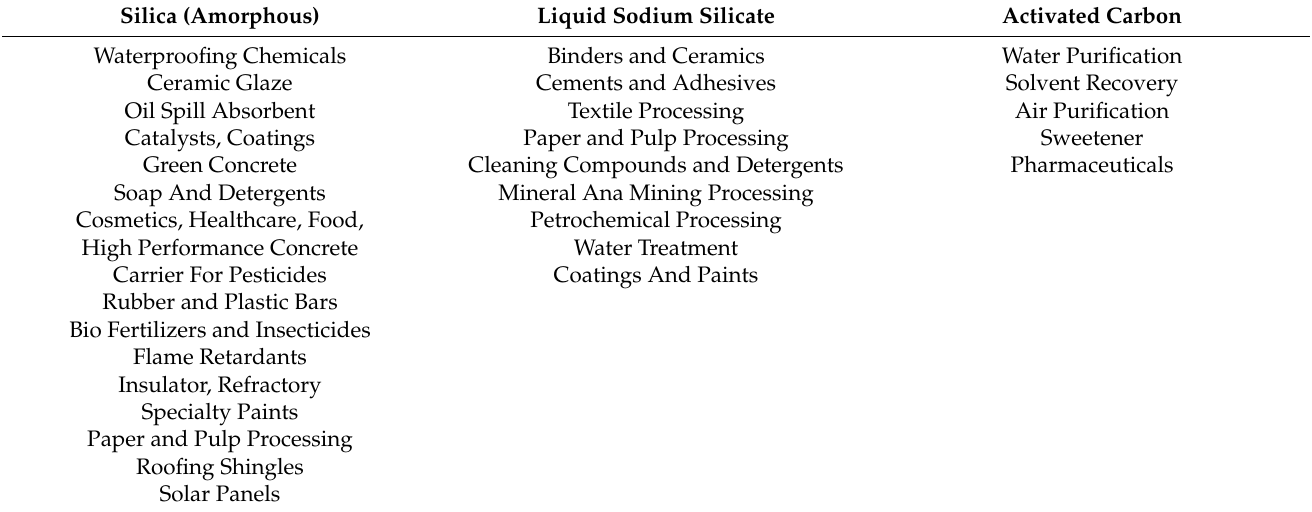
Table 9. Some applications of RHA [34].